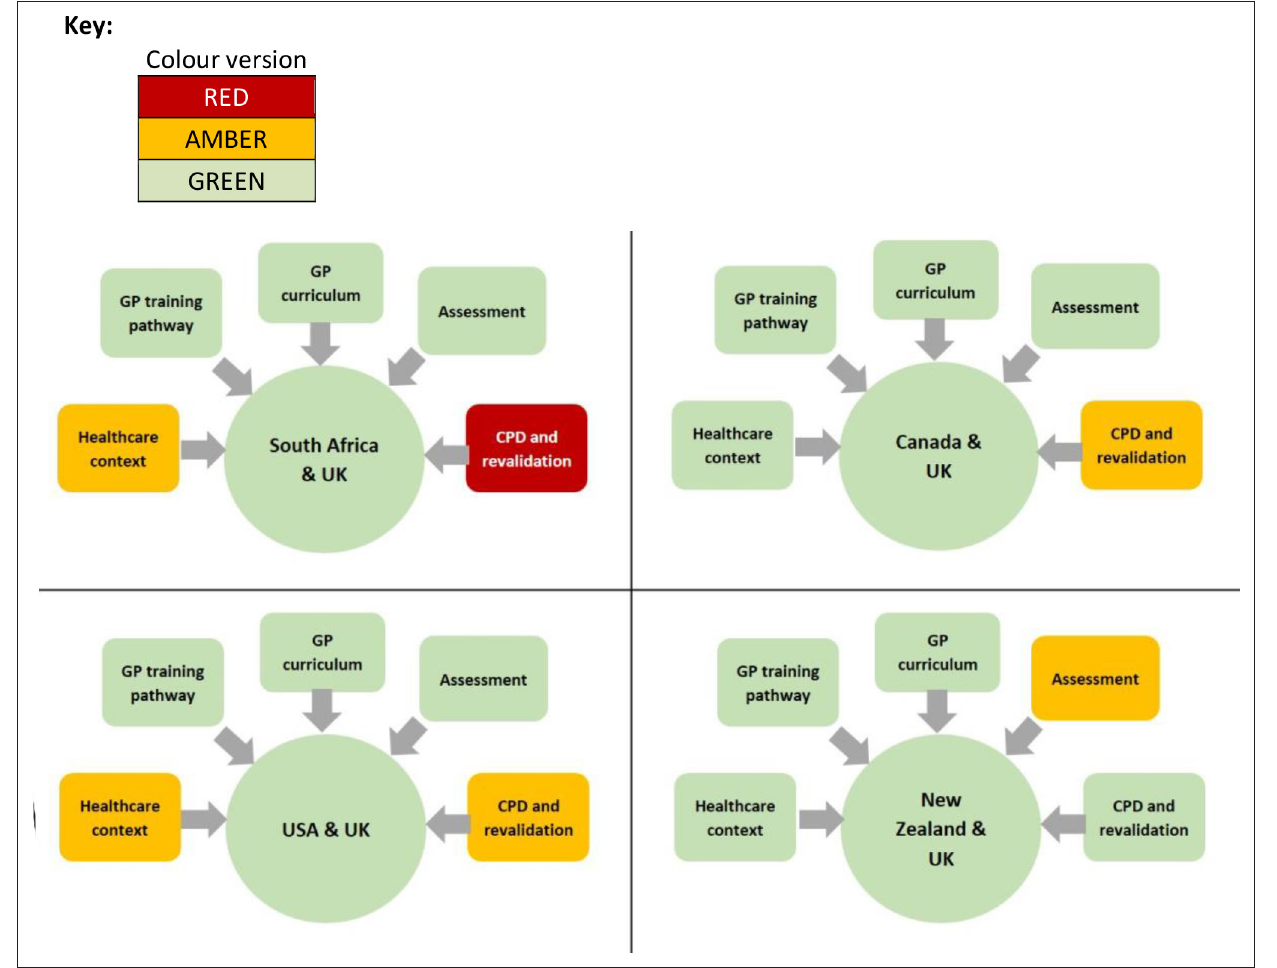
Figure 2 Results of mapping South Africa, Canada, the US, and New Zealand to the UK. CPD = continuing professional